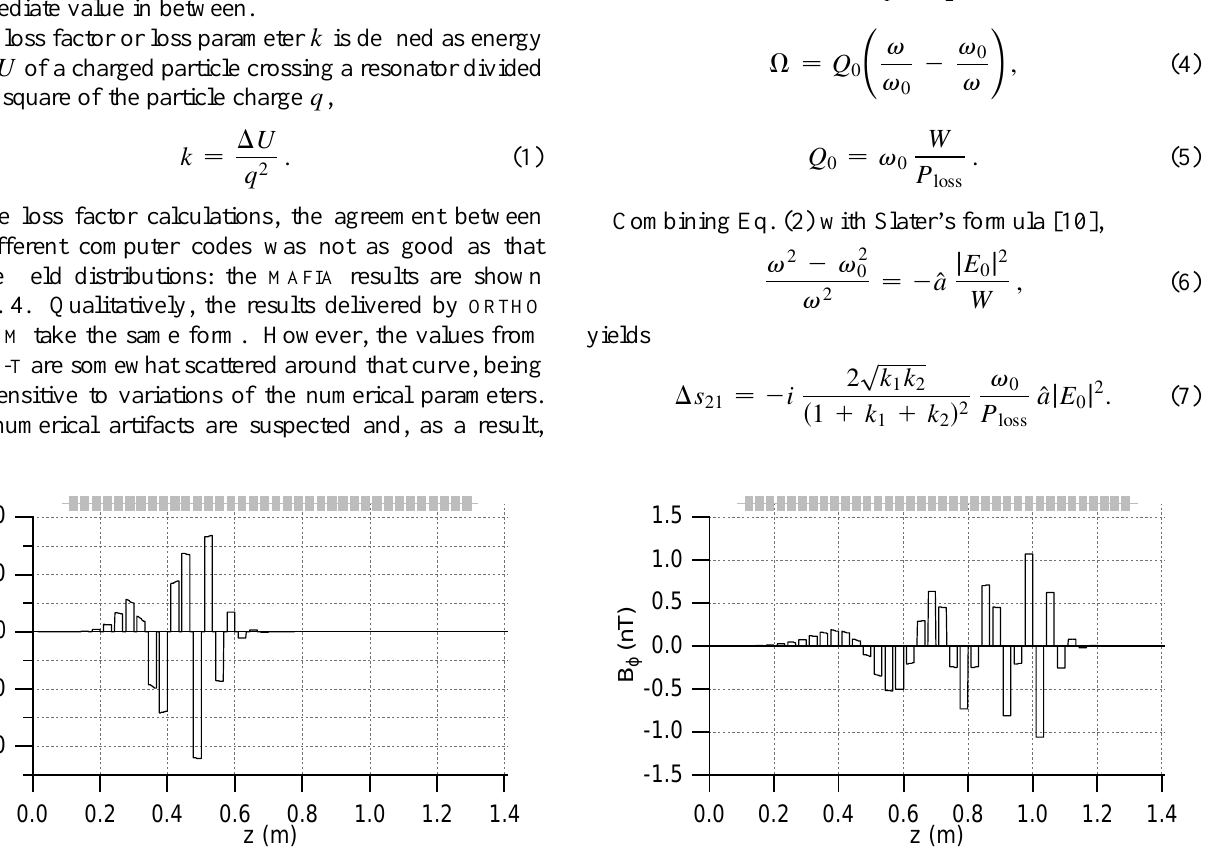
FIG. 2. Field distribution of a trapped mode from the first dipole passband (cid:115) (cid:102) (cid:48) (cid:173) (cid:52)(cid:48)(cid:57)(cid:53)(cid:46)(cid:55) MHz (cid:100) .